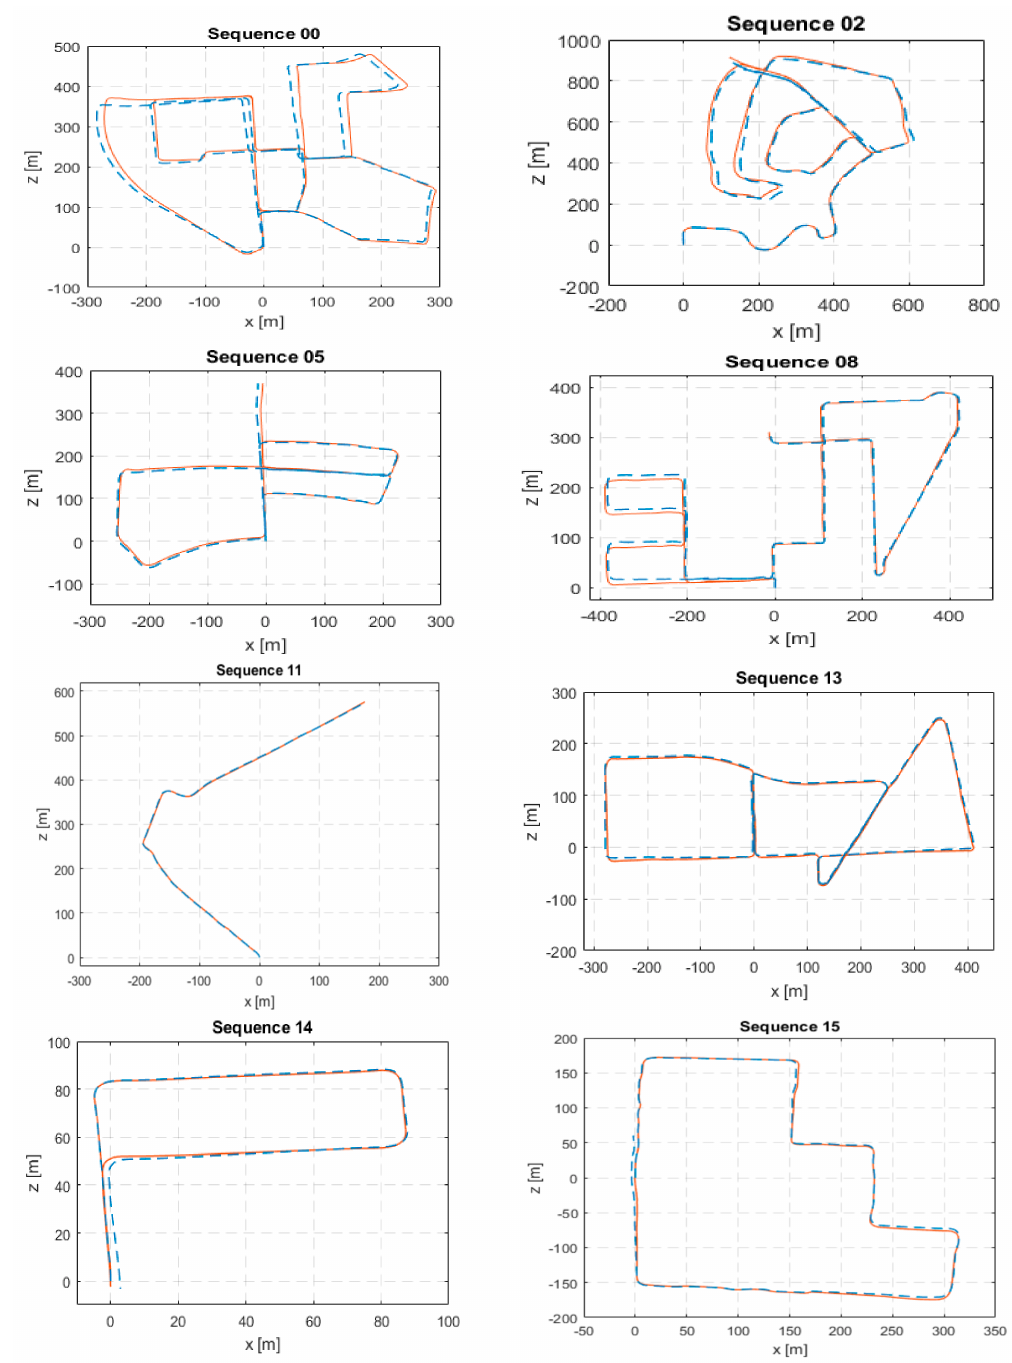
Figure 2. Estimated trajectory (dashed blue) from lightweight visual tracking (LVT) against ground truth (solid red) in KITTI dataset training sequences (00, 02, 05, 08) and evaluation sequences (11, 13, 14,